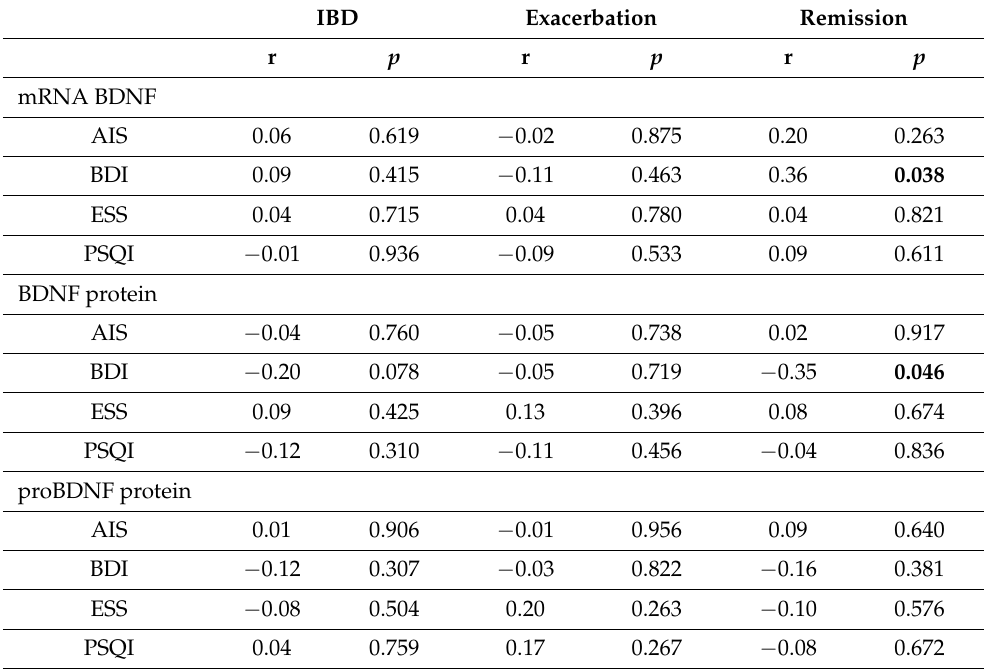
Table 4. Correlations between level of expression of studied neurotrophins and questionnaire